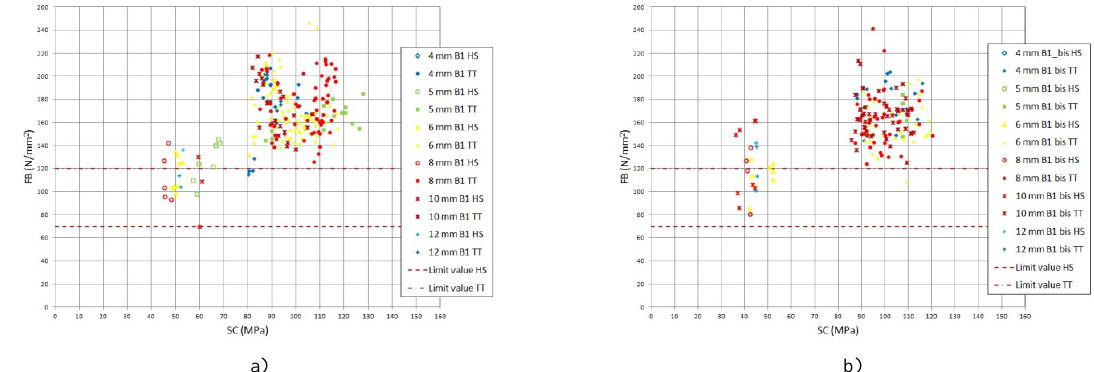
Fig. 6 Correlation of surface compressive stress (SC) versus flexural bending (FB): a) for B1 coated glass; b) for B1_bis coated glass